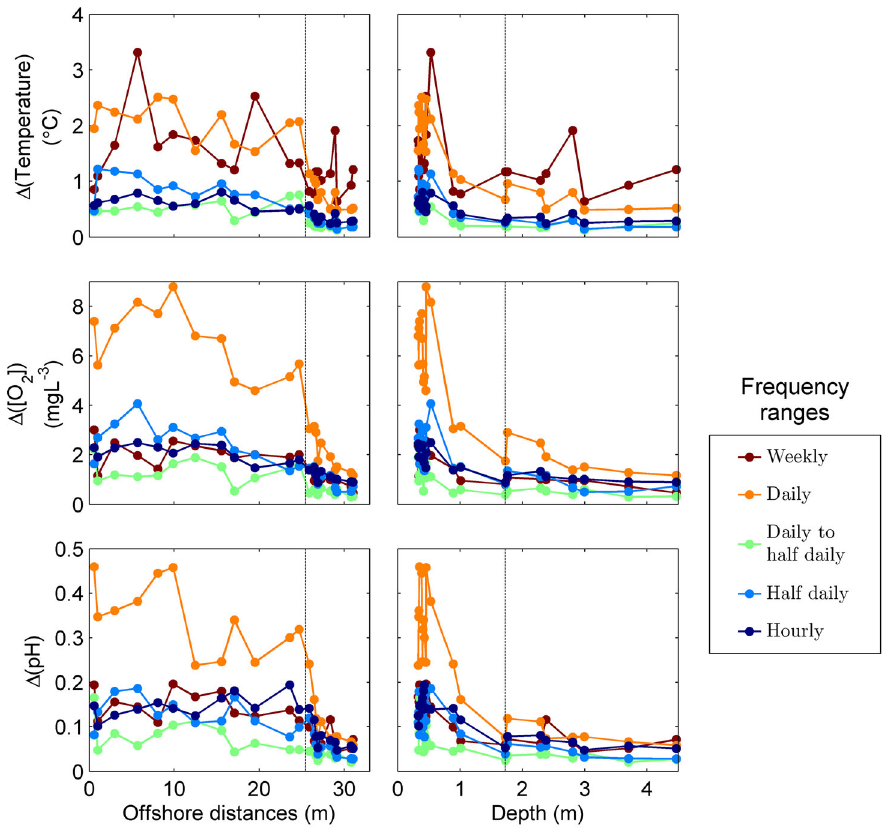
Figure 6. Amplitudes of oscillations by frequency ranges. Amplitudes A are calculated from decomposed variances, assuming that all parameters have a normal distribution, as A =4 ? ! s 2. Vertical dash lines mark the position of the long-term time series